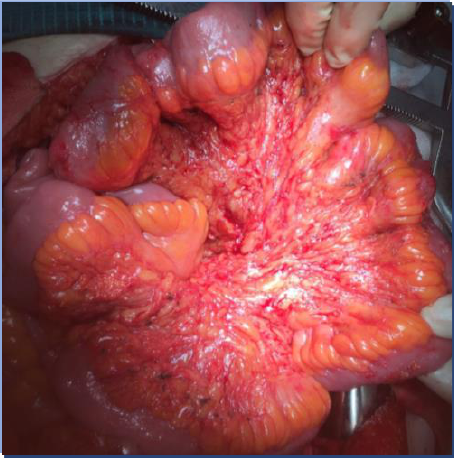
In some selected cases, mesenteric peritonectomy may be indicated, when this is associated with a chance of R0 resection and small bowel wall is not involved (Figure 3).